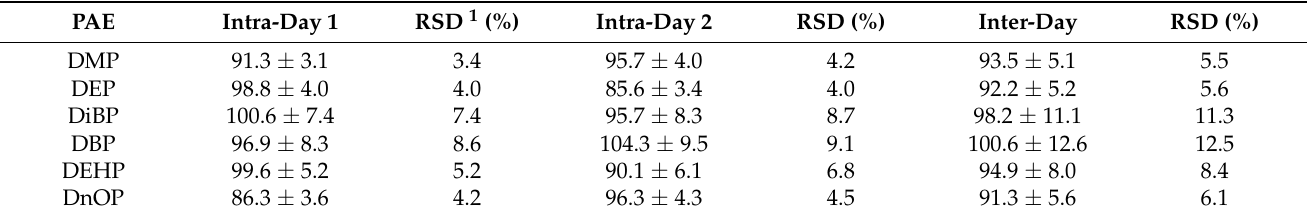
Table 5. Inter- and intra-day precision (%) with relative standard deviation (%).